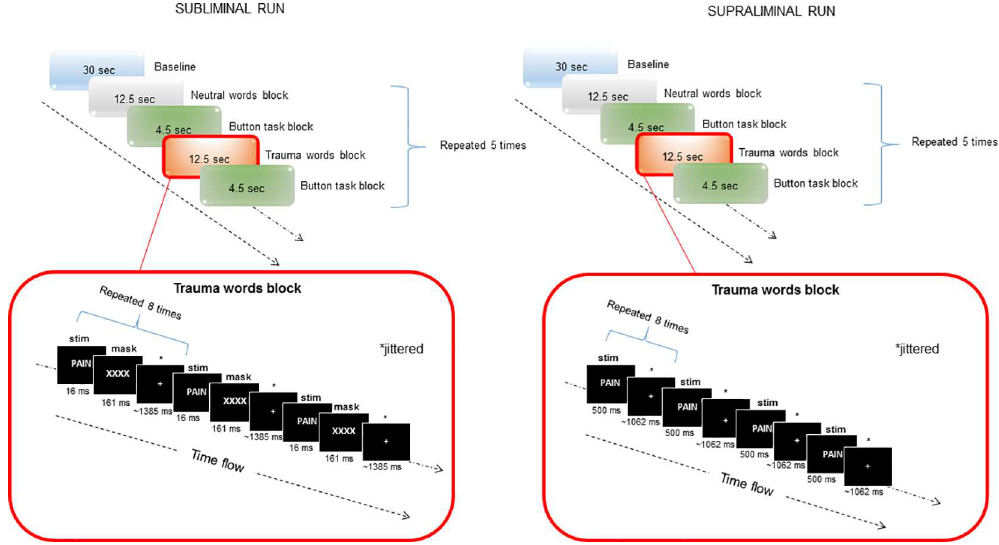
Fig 1. Graphical depiction of the experimental design.Subliminal session is depictedon the left, supraliminal sessionon the right.Above panelsdepictthe block design.Below panelsdepicttiming windowsand stimuluspresentationwithinword blocks (thetrauma-related word block in thiscase). Note: ms: milliseconds; sec: